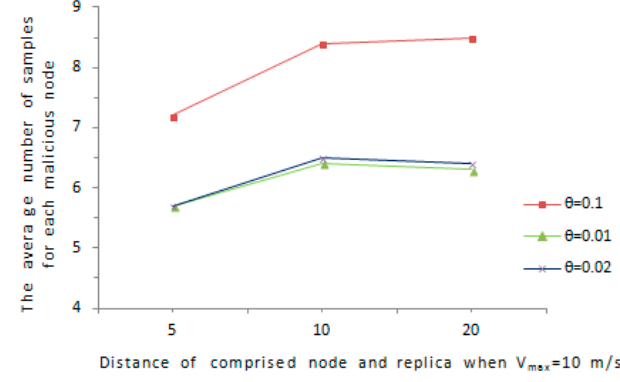
Figure 10. The average number of samples versus D when V max = 10 m/s.